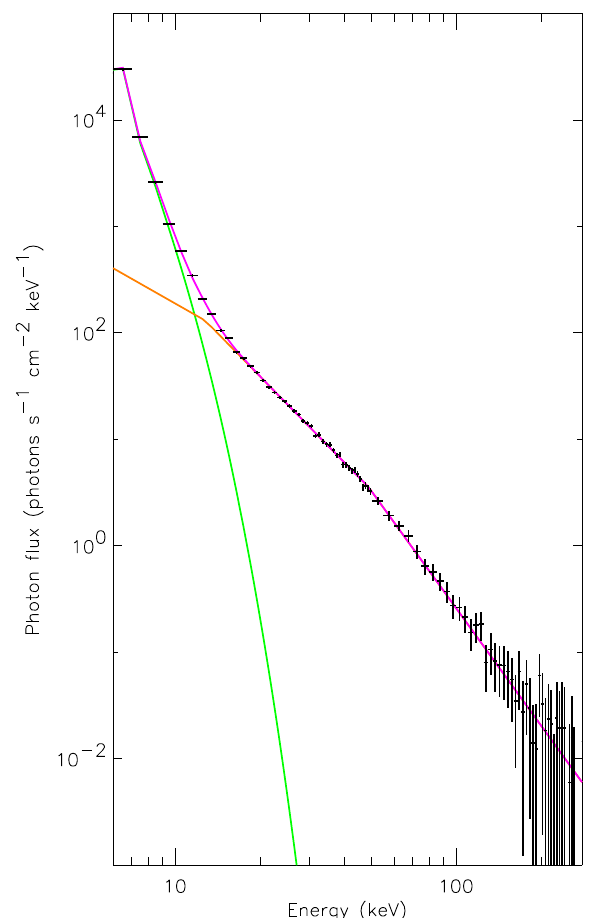
Fig. 7 X-ray spectrum of a flare observed by the RHESSI satellite. The soft part is fitted with a thermal component ( green ) having a temperature of 16.7 MK, and the high-energy part with a power law having two breaks at 12 keV (possibly due to the acceleration process if real) and at 50 keV, of which the origin is unknown. Image courtesy of Paolo Grigis, for details see Grigis and Benz